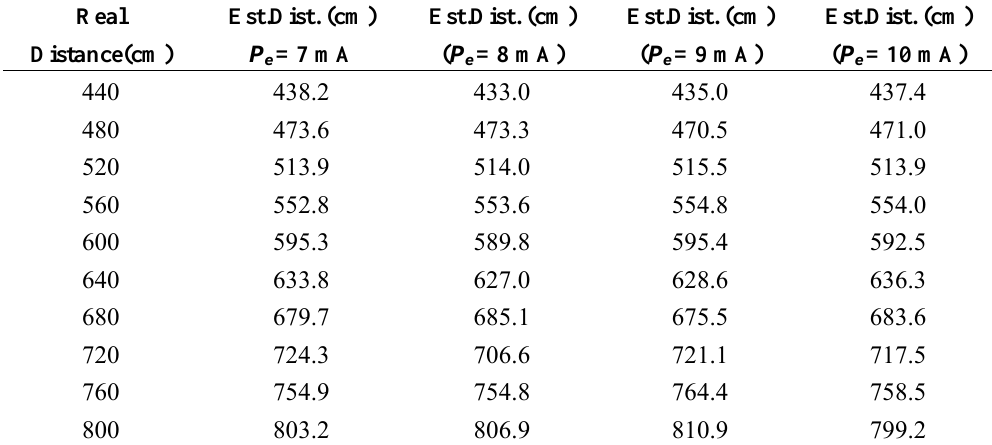
Table 1 . Distance Estimation for each polarization